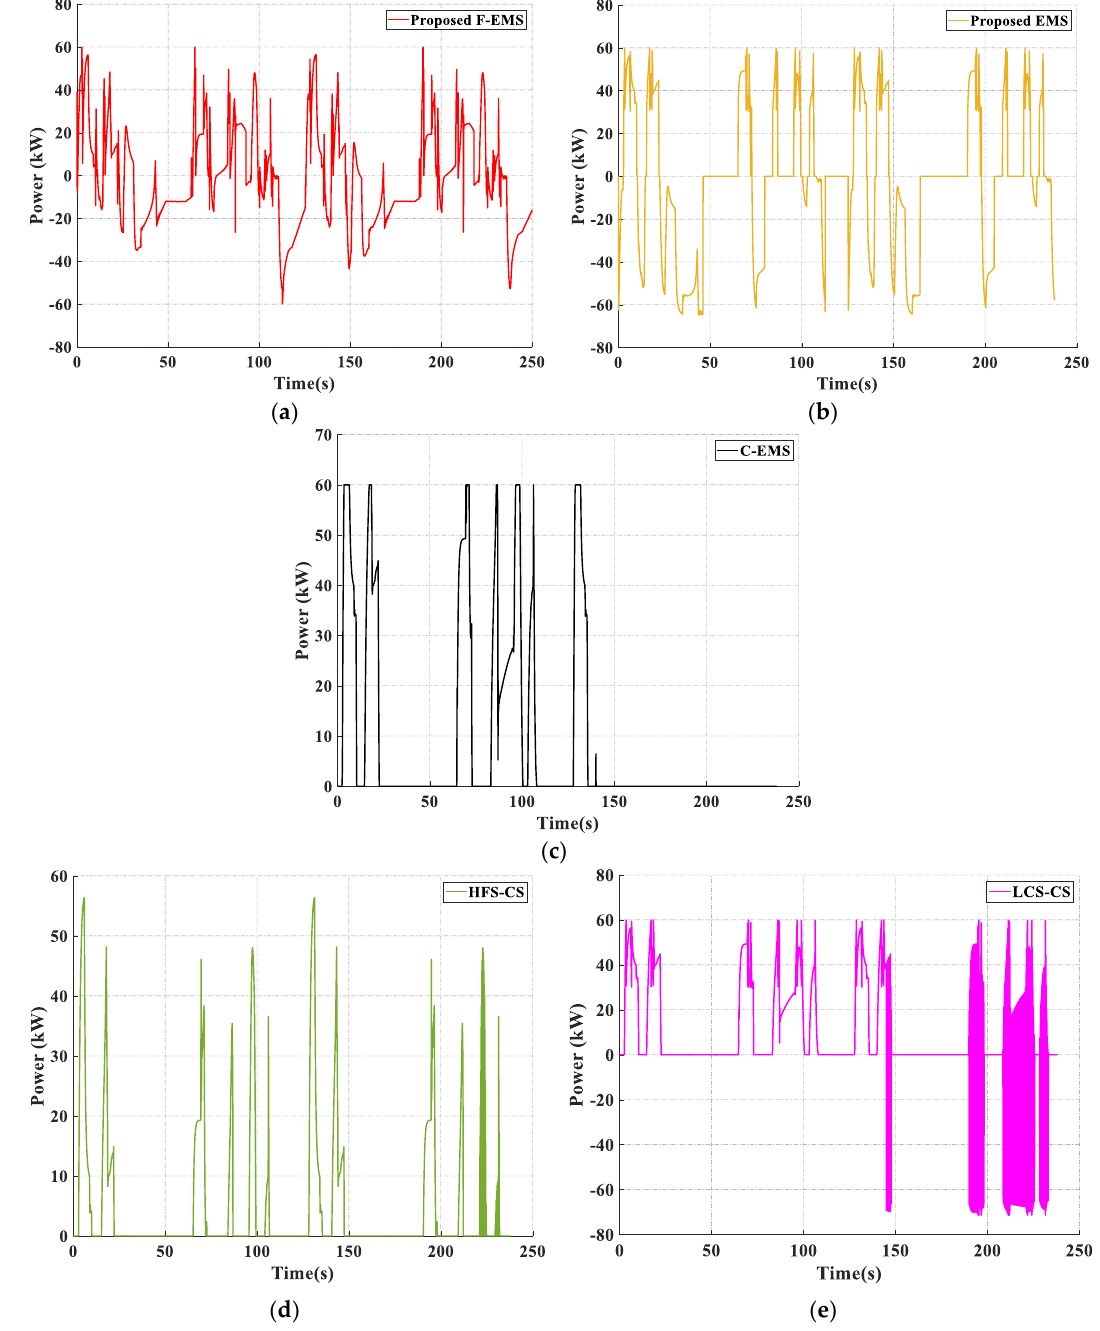
Figure 13. Power released from the SC for the five strategies: ( a ) proposed F–EMS, ( b ) proposed EMS, ( c ) conventional EMS (C–EMS), ( d ) HFS–CS, and ( e ) LCS–CS.